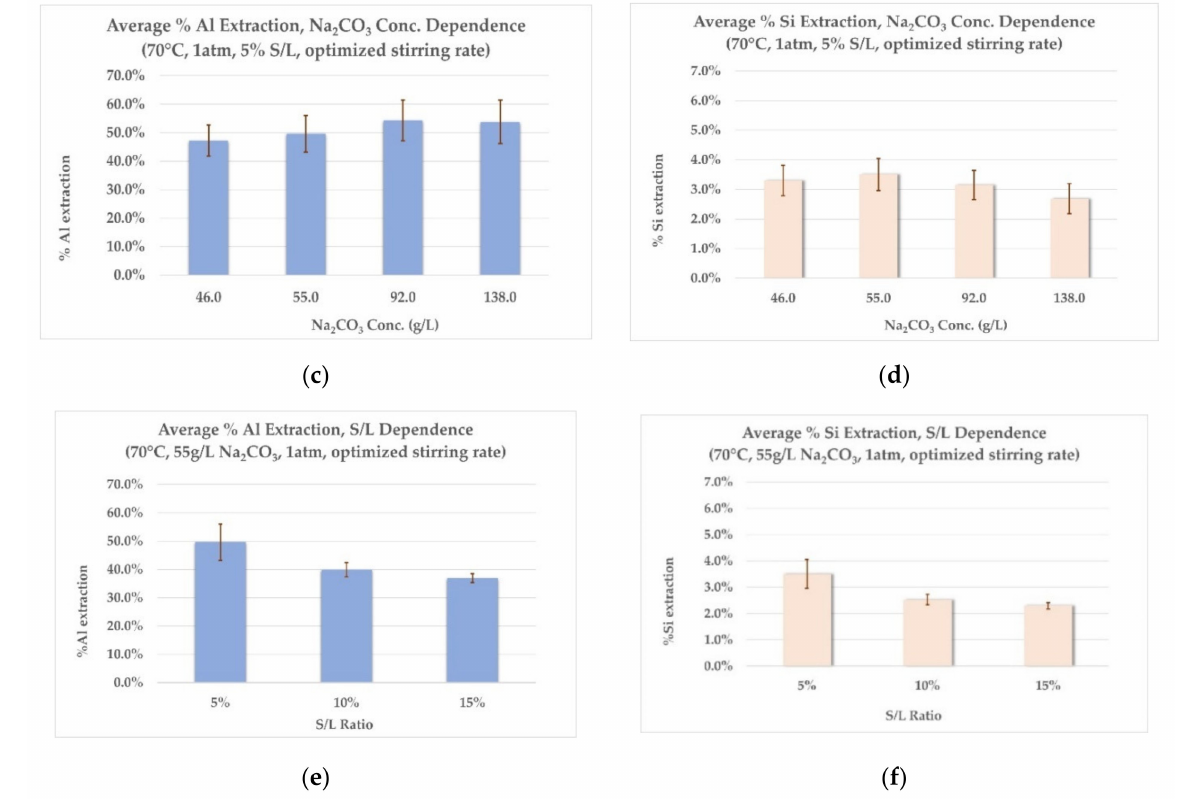
Figure 5. Laboratory scale extraction results: ( a ) effect of temperature on Al extraction, ( b ) effect of temperature on Si extraction, ( c ) effect of Na 2 CO 3 concentration on Al extraction, ( d ) effect of Na 2 CO 3 concentration on Si extraction, ( e ) effect of S/L ratio on Al extraction, ( f ) effect of S/L ratio on Si extraction. Table 5. Al and Si extraction rates in the washing solutions of the laboratory scale